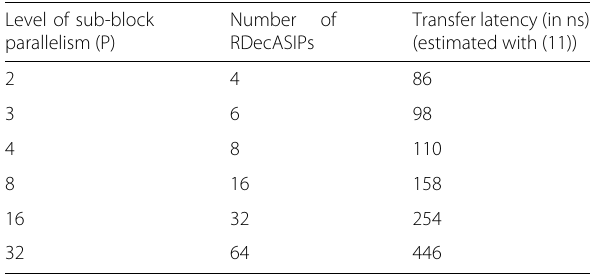
Table 5 Maximum throughput supporting frame-by-frame configuration scenario in serial decoding with 64 RDecASIPs,